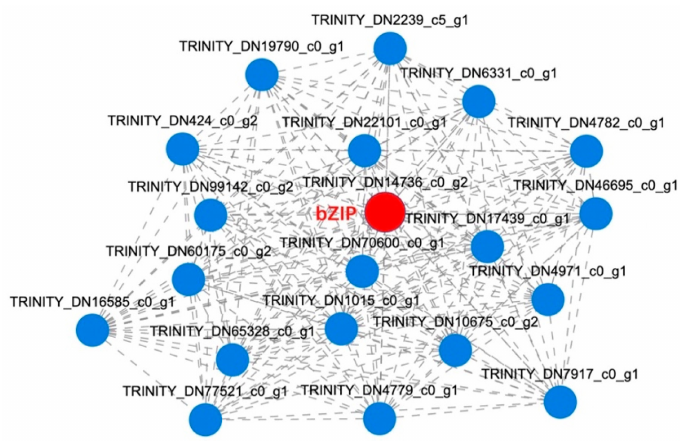
Figure 8. Co-expression network of hub genes in module